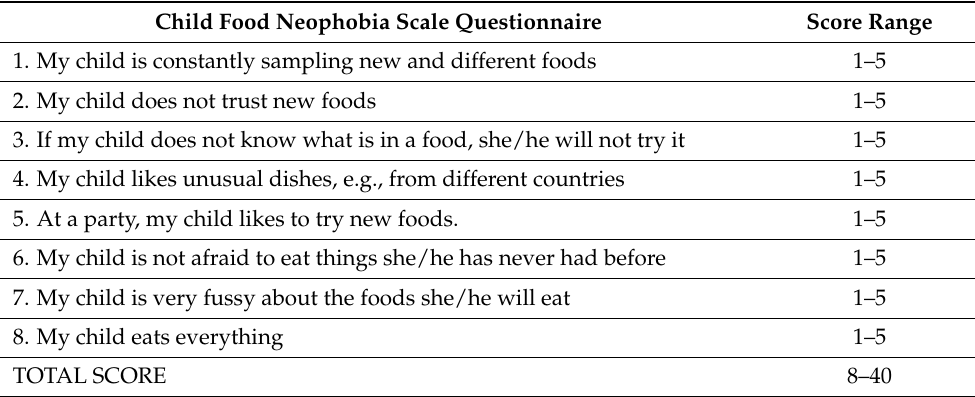
Table 10. Child Food Neophobia Scale